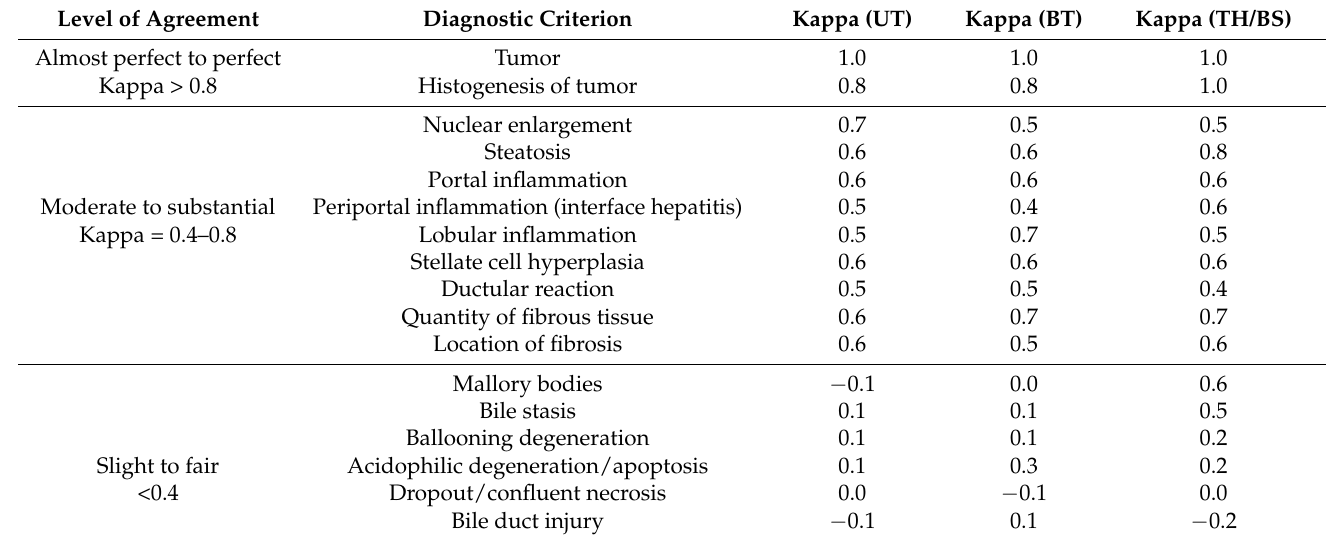
Table 2. Reproducibility of histopathologic